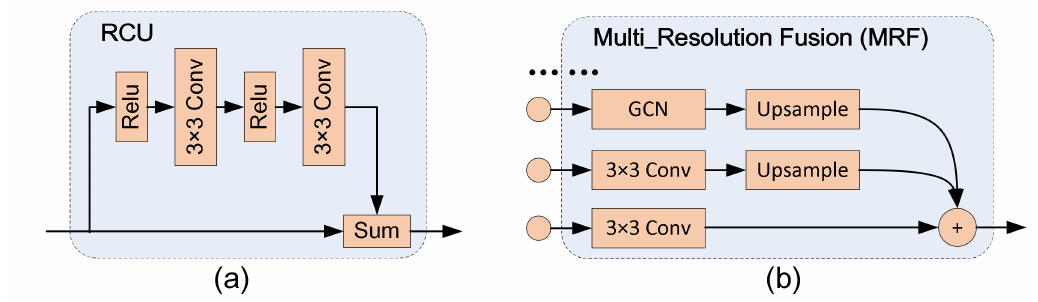
Figure 6. ( a ) the structure of RCU. ( b ) the structure of